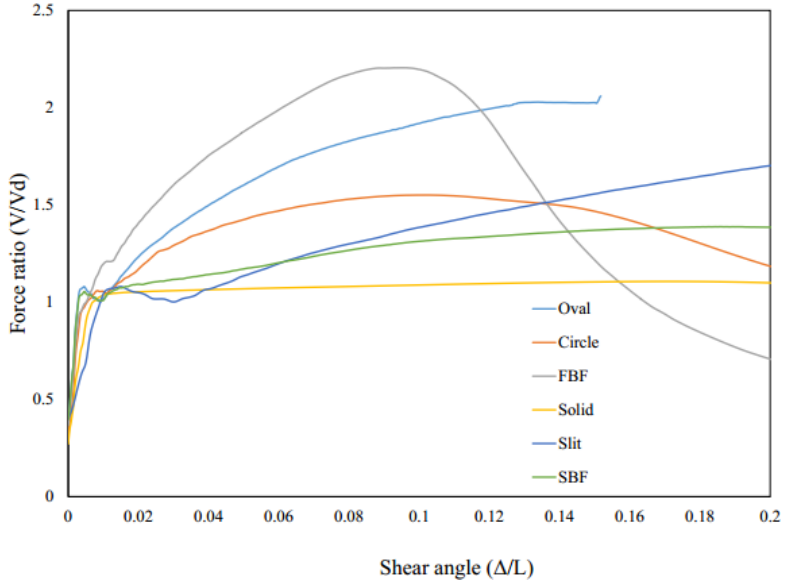
Figure 21. Pushover analyses curves for various innovative PRL fuse systems. Table 6. The computational results for PRLs.